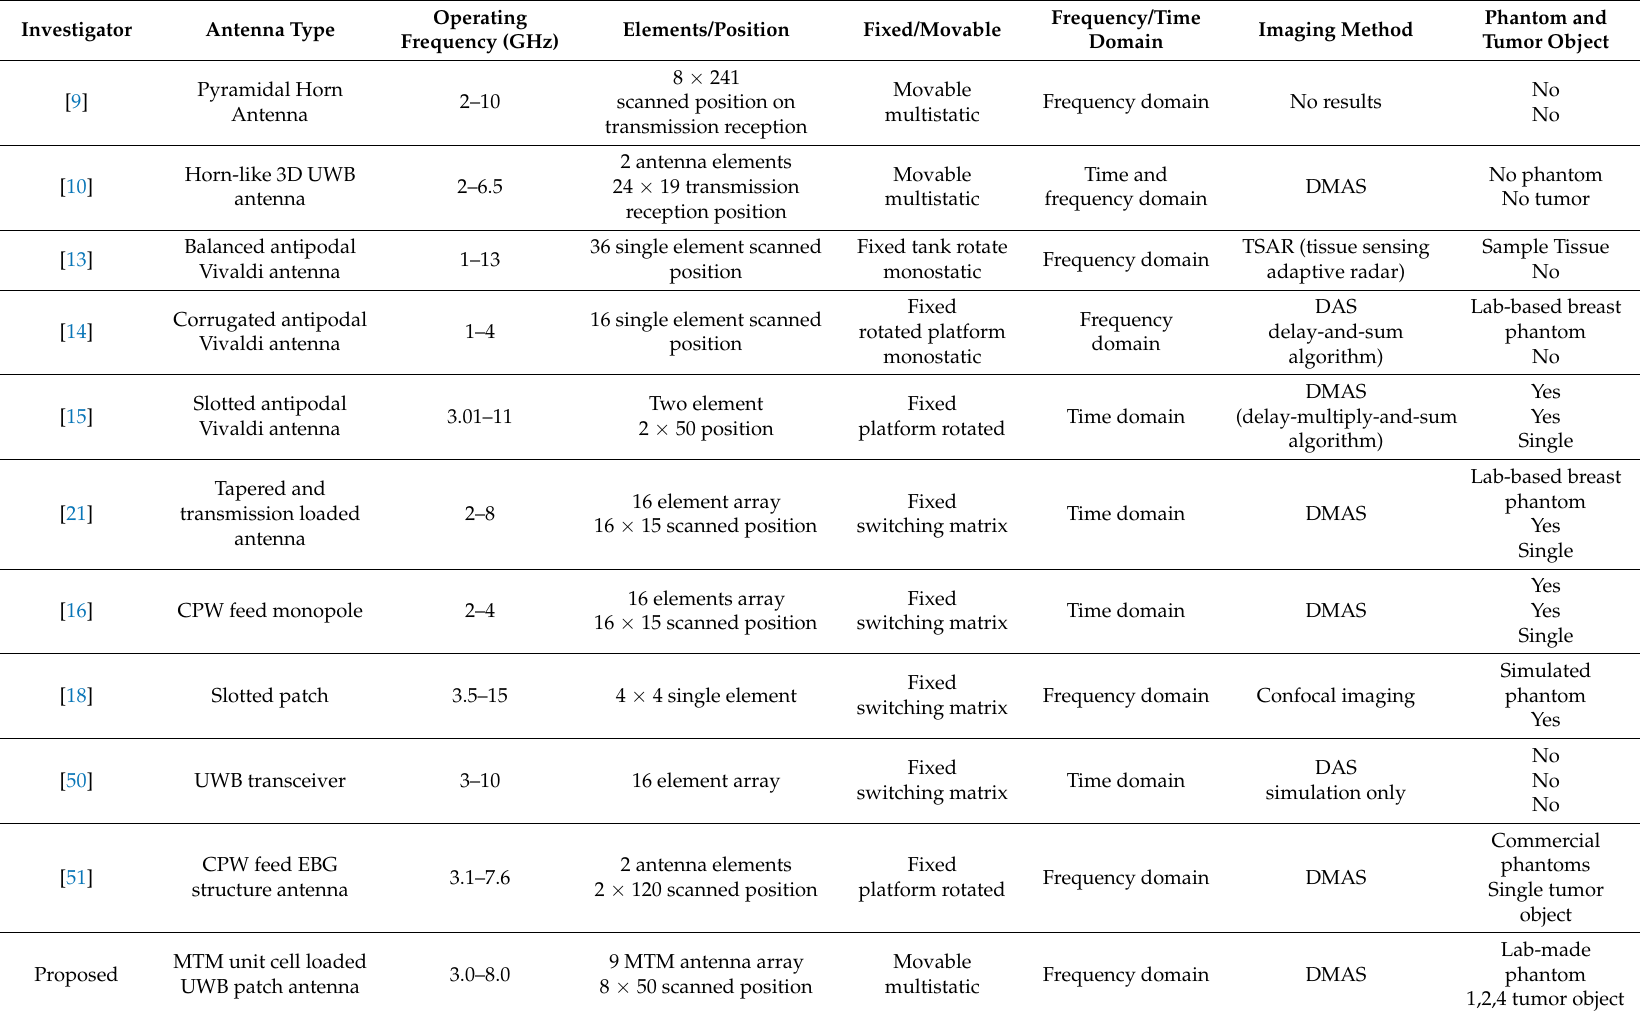
Table 4. Comparison of the existing imaging system with proposed